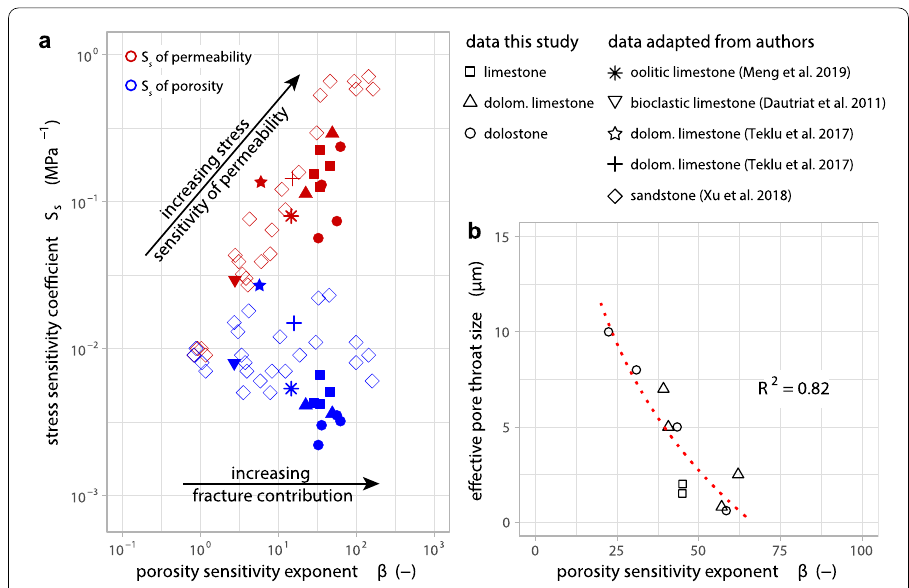
Fig. 12 a Relationship between stress sensitivity coefficients and the porosity sensitivity coefficient β . The stress sensitivity coefficients S Φ s for porosity and S k s for permeability are compared with a set of data from different authors. While S Φ s shows no significant correlation with β , S k s is clearly increasing with increasing β . Higher values of β indicate a progressively increasing contribution of fracture pores and micro-fractures to the effective permeability network and result in higher S k s values. Data for sandstone are taken from Xu et al. (2018) and for limestone compiled from Meng et al. (2019), Teklu et al. (2018), and Dautriat et al. (2011). b Porosity sensitivity is related to the effective pore throat size controlling the flow through the pore network. The exponent β increases with decreasing pore throat size, which indicates a decoupling of the stress sensitivity from porosity and